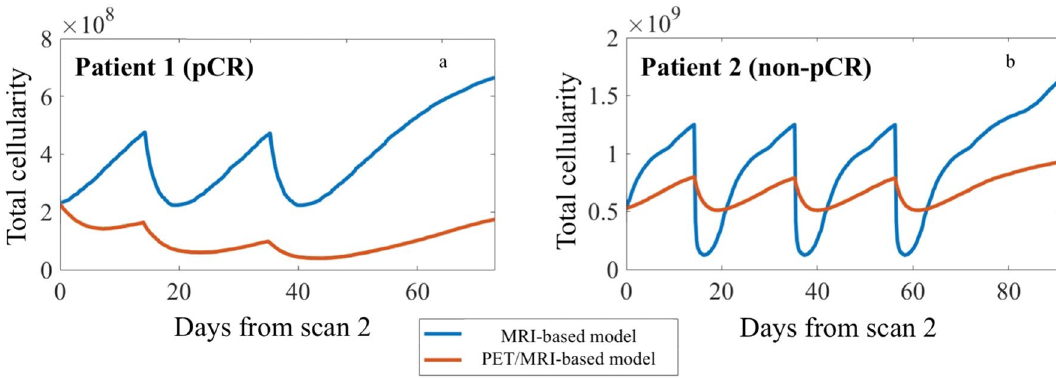
Figure 6. Tumor response curves for total cellularity predicted by the MRI-based (blue curve) and PET/ MRI-based model (orange curve) for each patient. Each panel depicts the predictions for total tumor cellularity from the time of scan 2 (day 0) to the time of surgery (end of simulation) for patient 1 (panel a) and patient 2 (panel b). Note that patient 1 received two doses of therapy between her second scan and surgery,